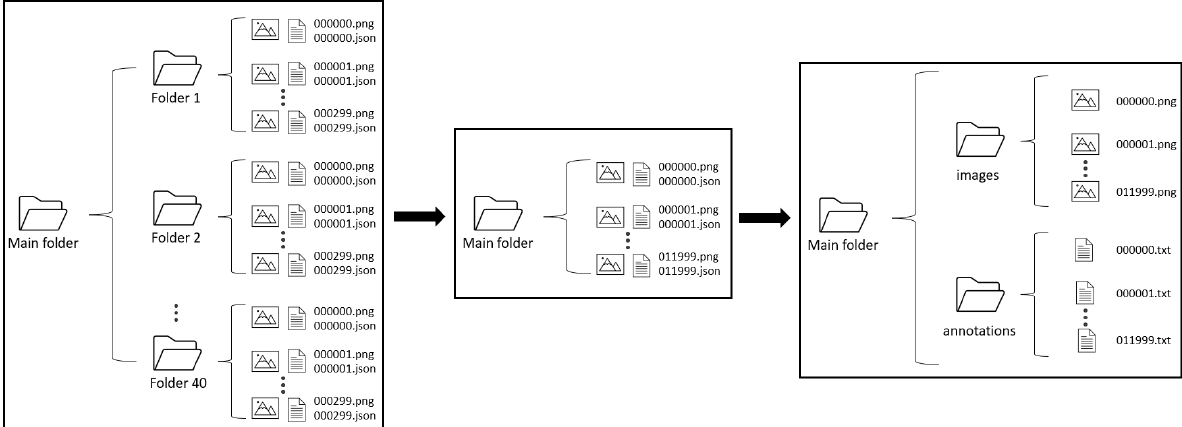
Figure 7. Data structure for input data. Images with associated metadata are saved in separate folders for each randomized